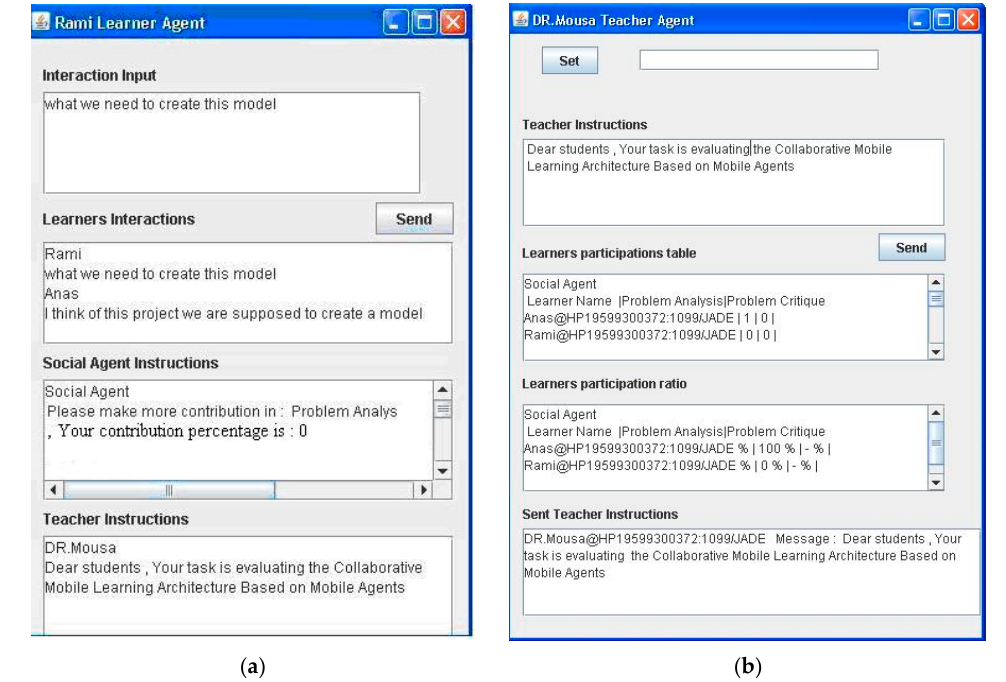
Figure 18. The GUIs of ( a ) the learner agent and ( b ) the teacher agent.